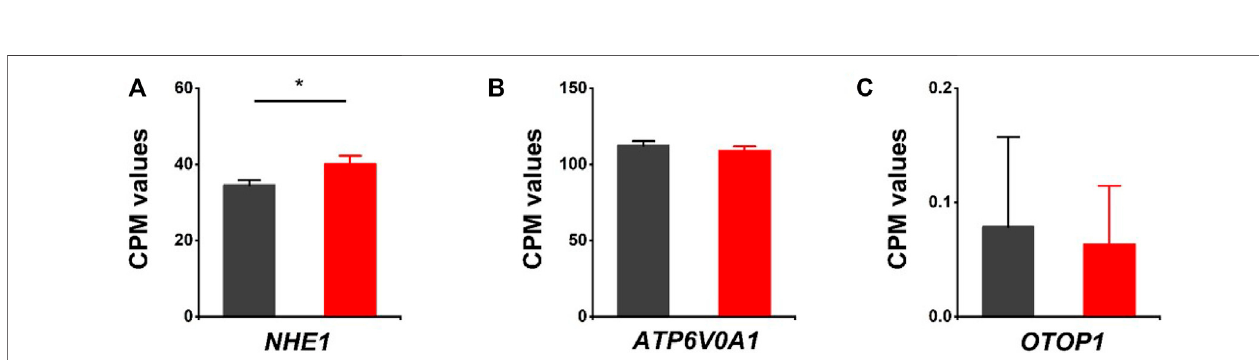
FIGURE 4 | Differentially expressed genes related to other proton transporters/channels in HVCN1 − / − hearts. Comparing relative gene expression levels of proton transporters between WT (black) and HVCN1 − / − (red) including sodium-hydrogen exchanger 1 ( NHE1 ) (A) , a1-subunit of the V 0 domain of V-type proton ATPase ( ATP6V0A1 ) (B) , and otopetrin proton channel 1 ( OTOP1 ) (C) , n = 4 independent experiments for RNA-seq; * p < 0.05.